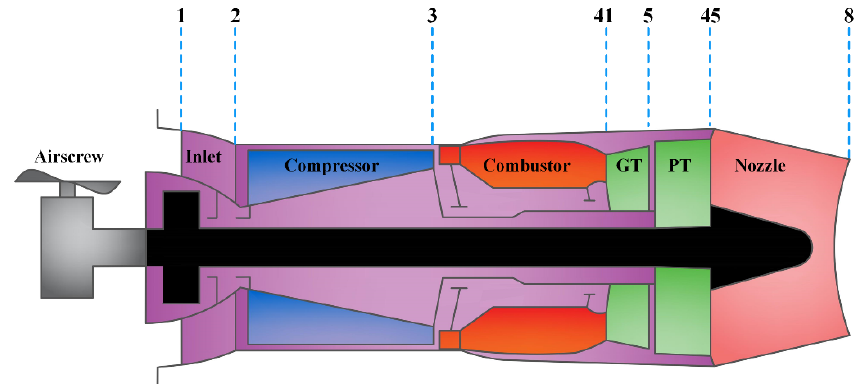
Figure 1. The layout of turboshaft engine.